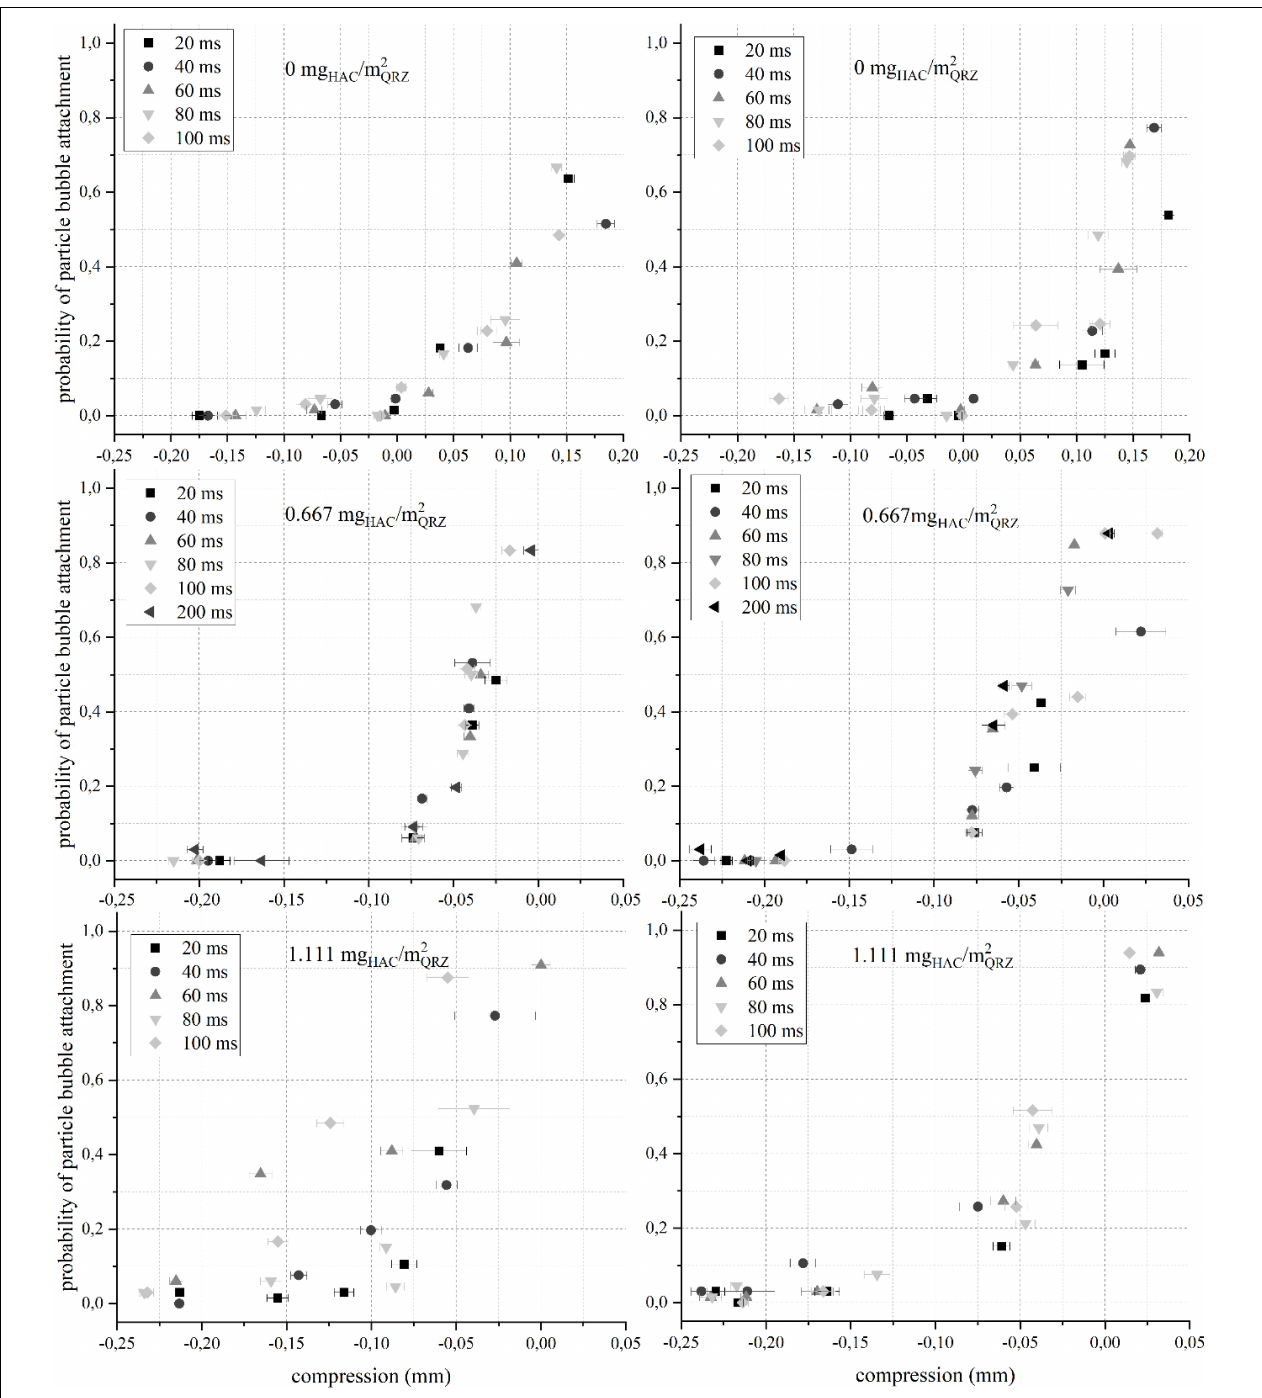
FIGURE 3 | The probability for an attachment between a QRZ particle and an air bubble immersed in a NaCl (left) or MgSO 4 (right) solution at pH 7 over the particle-bubble distance (compression = − H) for different contact times and HAC concentrations. The error bars are 95% confidence intervals. Note that the abscissa value range is not the same in all